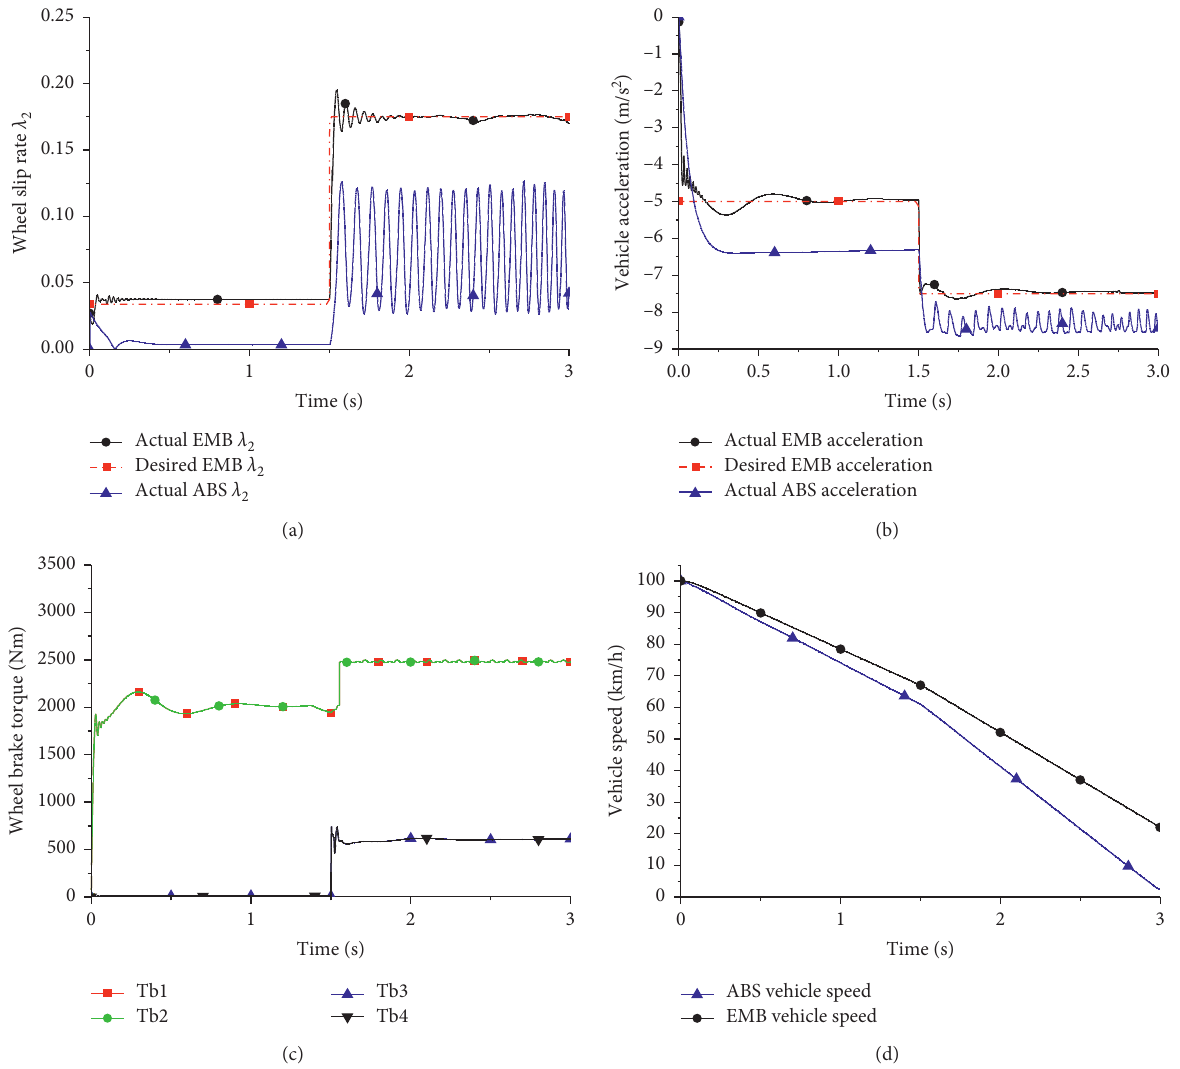
Figure 12: Dry asphalt pavement, switch medium comfort brake to emergency brake. (a) Wheel slip rate. (b) Vehicle acceleration. (c) Wheel brake torque. (d) Vehicle